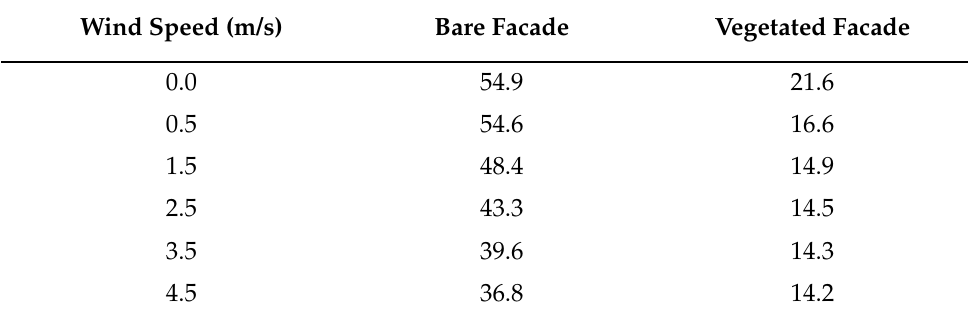
Figure 5. Heat flux distribution over time at the interior surface of the brick wall with canopy— sensitivity to wind speed, v : ( ∗ ) 0.0 m/s; ( ◦ ) 0.5 m/s; ( (cid:3) ) 1.5 m/s; (+) 2.5 m/s; ( × ) 3.5 m/s; ( (cid:5) ) 4.5 m/s. Table 2. Maximum indoor heat fluxes q int (W/m 2 ) through the porous brick wall without and with